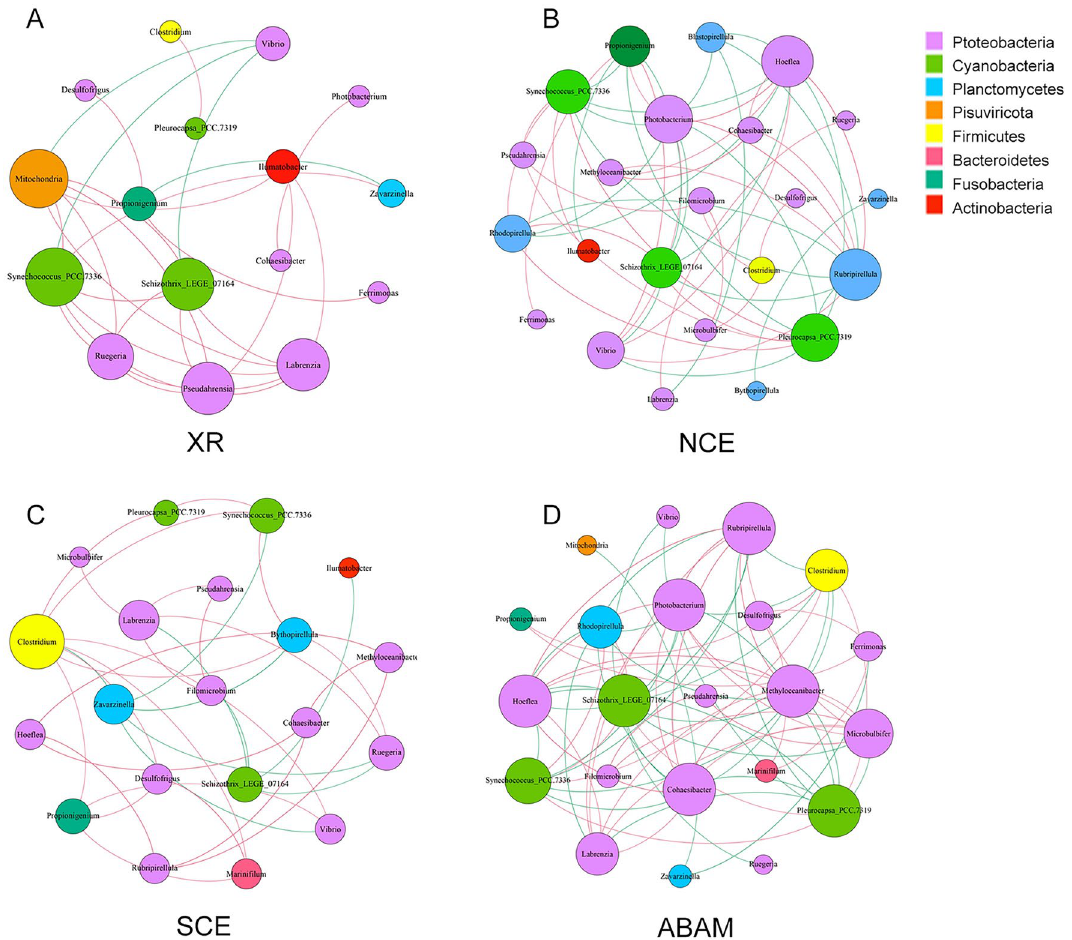
Figure 7. ( A ) A map of Weizhou Island created using Photopea online program (https:// www. photo pea. com/). The unfilled circles illustrate position of the three chosen sites, A, B and C covering the 9 stations 4, 5, 6, 10, 11, 12, 16, 17, 18. One model of ABRs is placed in each of the indicated stations. Position of deployment and samples from natural reef (XR group) per station are indicated in the white boxes. Purple circle represents site A, station 5 (covering models’ number 10, 20, 59, As), red circle represents site B, station 11 (covering models’ number 25, 34, 36, Bs) and blue circle represents site C, station 17 (covering models’ number 40, 55, 58, Cs). ( B ) A sample of pictures taken during sampling process from both the surface of ABRs and XR from the three sites, credit to Amro